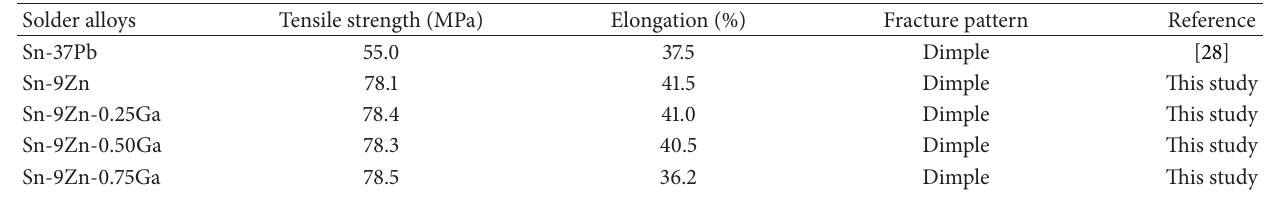
Table 3: The mechanical properties of the Sn-37Pb and Sn-9Zn- 𝑥 Ga solder alloys.